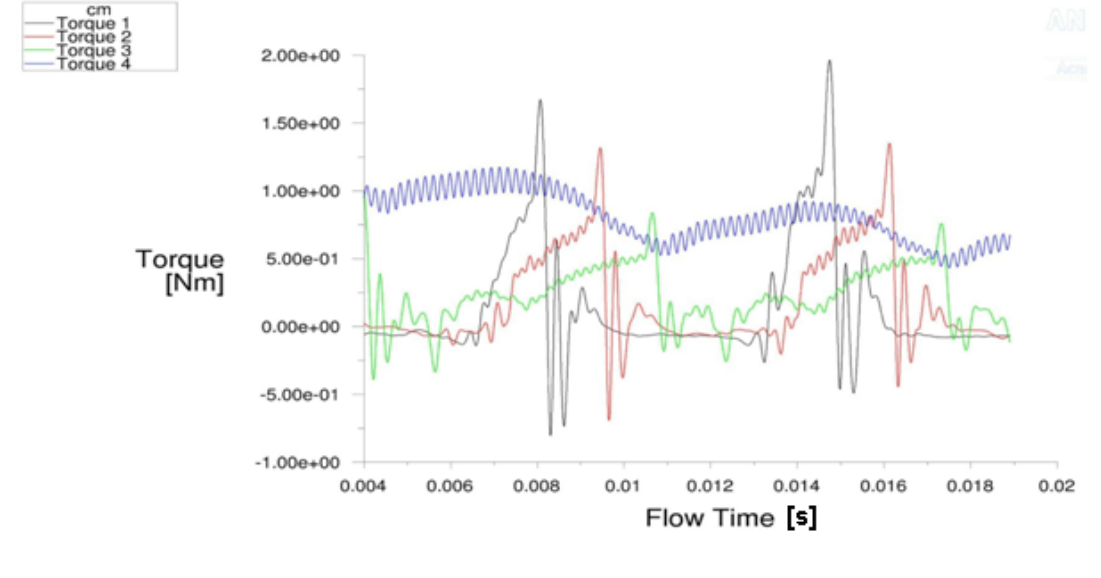
Figure 3: Plot of torque acting at a single rotor blade of subsequent turbine stages – stage 1 (Torque 1, black), stage 2 (Torque 2, red), stage 3 (Torque 3, green), stage 4 (Torque 4, blue – full admission supply).